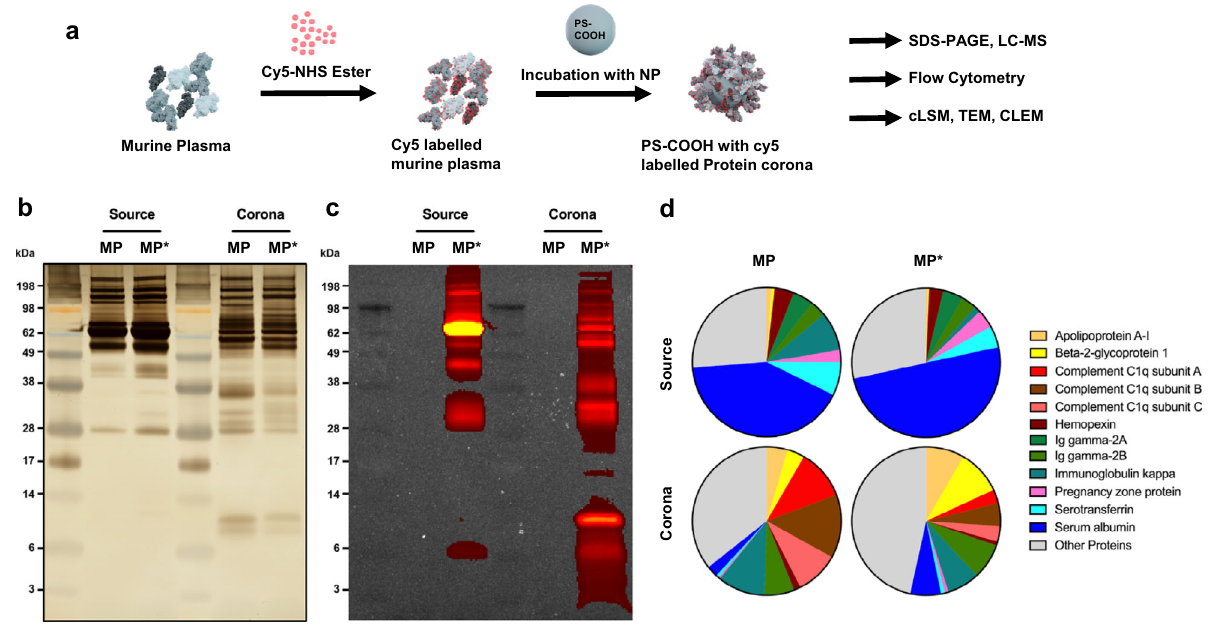
Fig. 1 | Protein analysis of unlabeled and Cy5-labeled murine plasma and pro- tein corona. a Murine plasma proteins were labeled with Cy5 by NHS-chemistry. Carboxyl-functionalized PS NPs were incubated in unlabeled and Cy5-labeled murineplasma, respectively,to formaproteincorona. b Unlabeledmurine plasma (MP), Cy5-labeled murine plasma (MP*), and associated protein corona samples were analyzed by SDS-PAGE and silver staining. Corona proteins were obtained